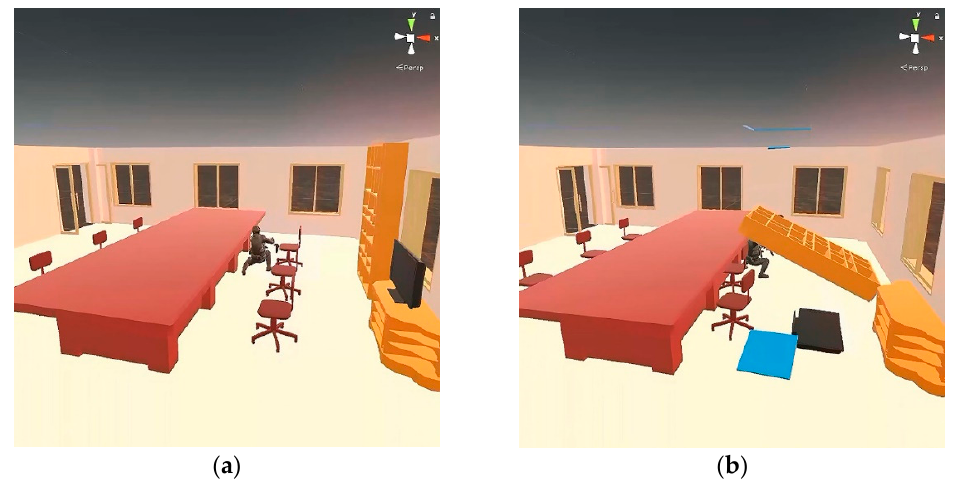
Figure 17. The second drill with the awareness of nonstructural damage, ( a ) response; ( b ) consequence.